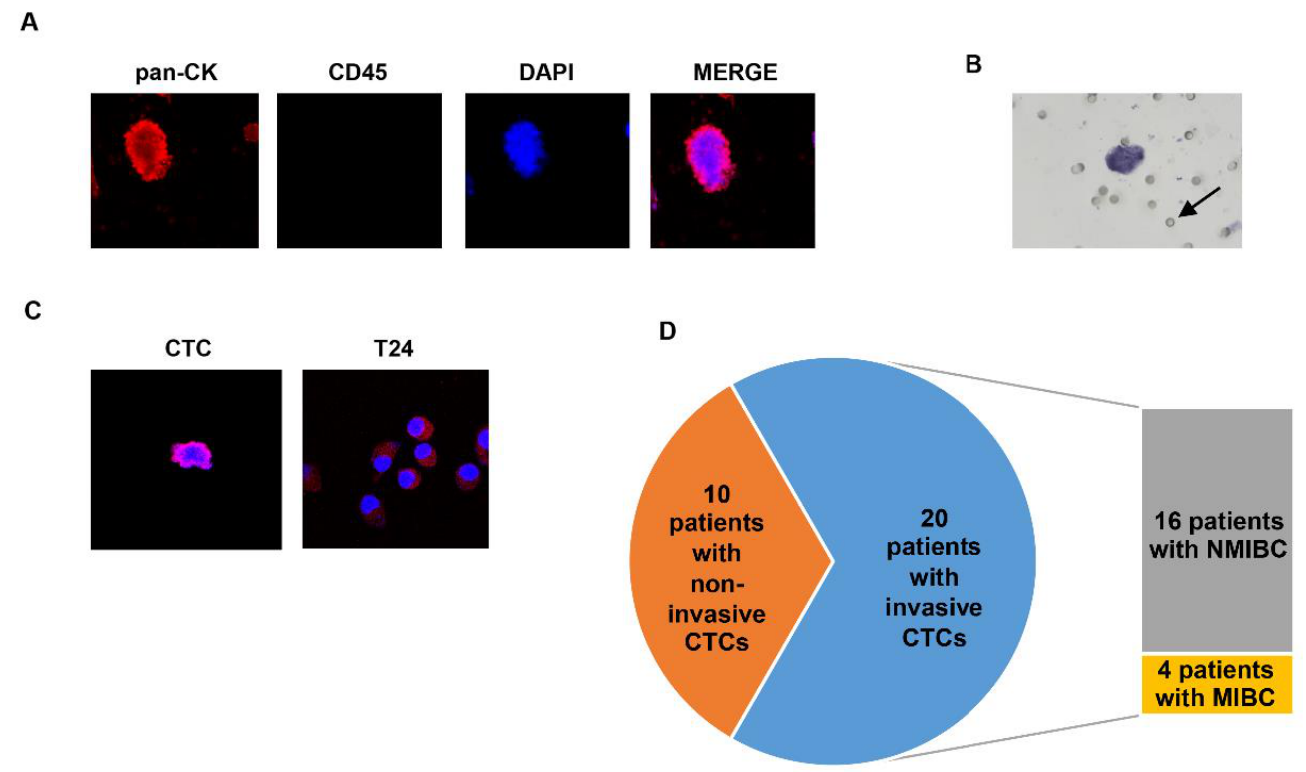
Figure 3. The characterization and functionality of the CTCs from BC patients. ( A ) The representative confocal microscopy image of the isolated CTCs stained with anti-human pan-CK and anti-human CD45 Abs. DAPI was used to counteract the nuclei. Magnification 60 × . ( B ) The representative light microscopy image of the CTCs, stained with toluidine blue, migrated on the membrane to the bottom face. The arrow indicates the pores of the transwell. ( C ) The representative confocal image of the CTCs and T24 cells that invaded the Matrigel in the transwell invasion assay. Cells were stained with pan-CK and DAPI, Magnification 60 × . ( D ) The percentage of patients who displayed CTCs with an invasive phenotype, as demonstrated by the transwell assay.